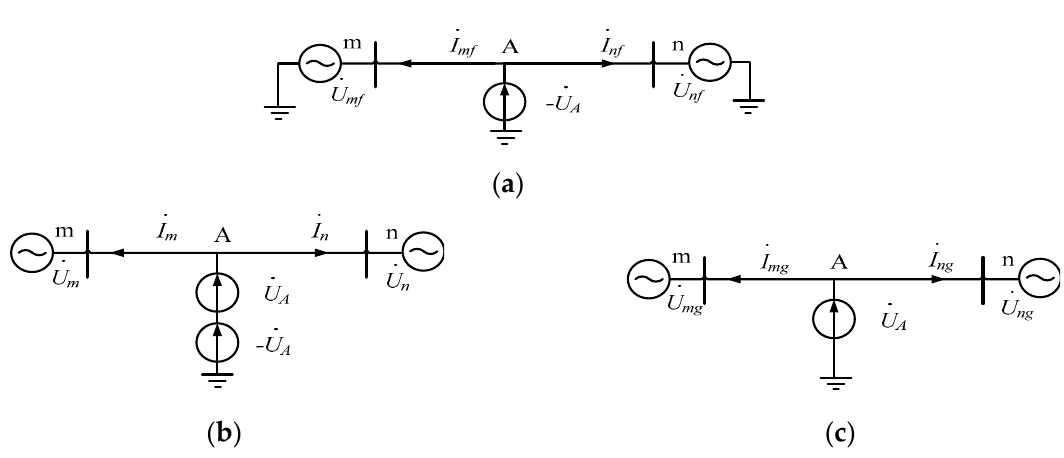
Figure 1. Power cable states of ( a ) fault component state (FCS); ( b ) power cable fault state (PCFS); and ( c ) normal state (NS).